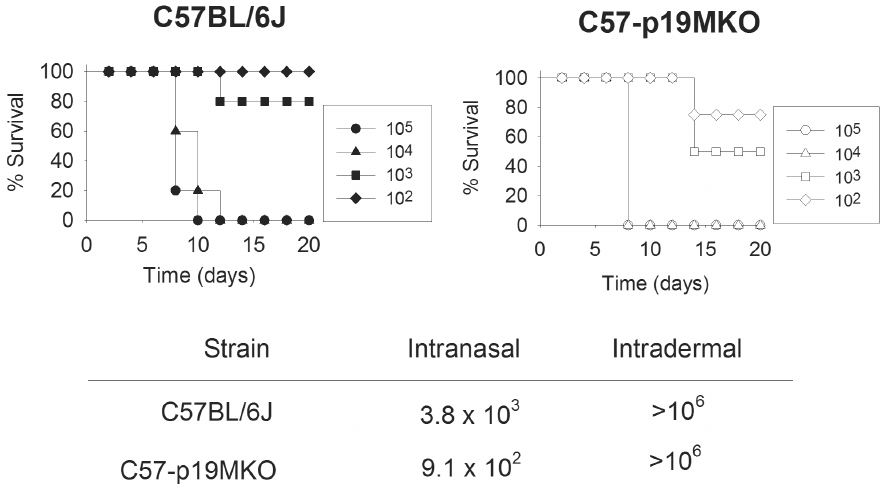
Figure 1. C57BL/6J and IL-23 deficient mice exhibit comparable survival patterns following IN or ID LVS infection. Groups of 5 to 10 WT mice and p19M KO mice were infected IN with LVS doses ranging from 10 1 –10 6 CFU (doses 10 1 and 10 6 not shown for clarity). For ID infections, groups of 5 WT mice and p19M KO were infected ID with LVS doses ranging from 10 4 –10 6 . The calculated LD 50 for IN and ID infections are shown (inset table). No mice from any ID-infected group succumbed to infection. Results shown are representative of three experiments of similar design and outcome. p19G KO mice were also included in some experiments with similar results (data not shown).